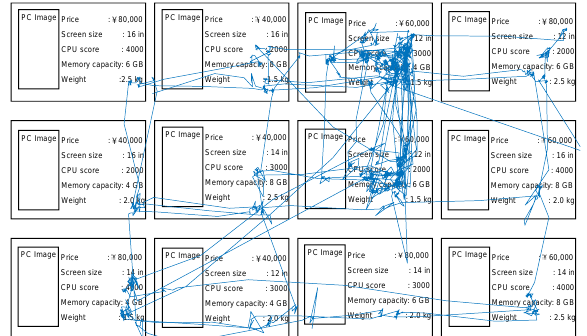
Figure 6. Example of gaze trajectory on the content. The de- scriptions in this figure are translations from the original Japa- nese same as Figure 5.